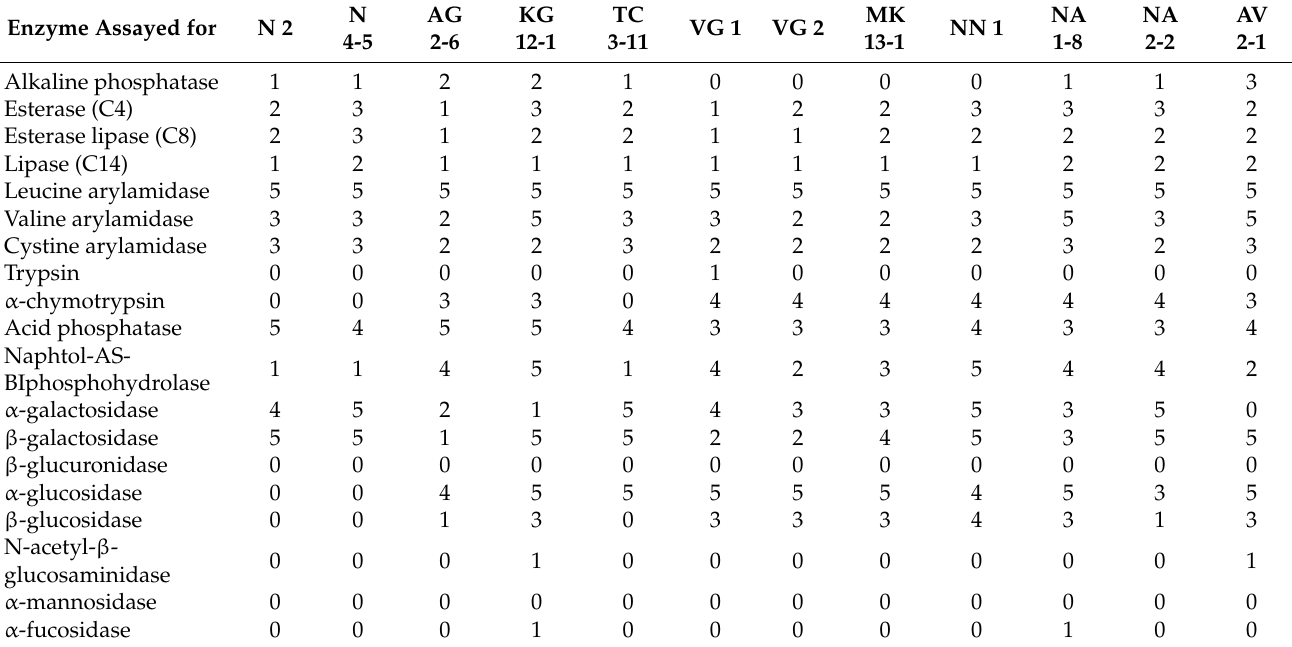
Table 2. Enzymatic activity of the newly isolated